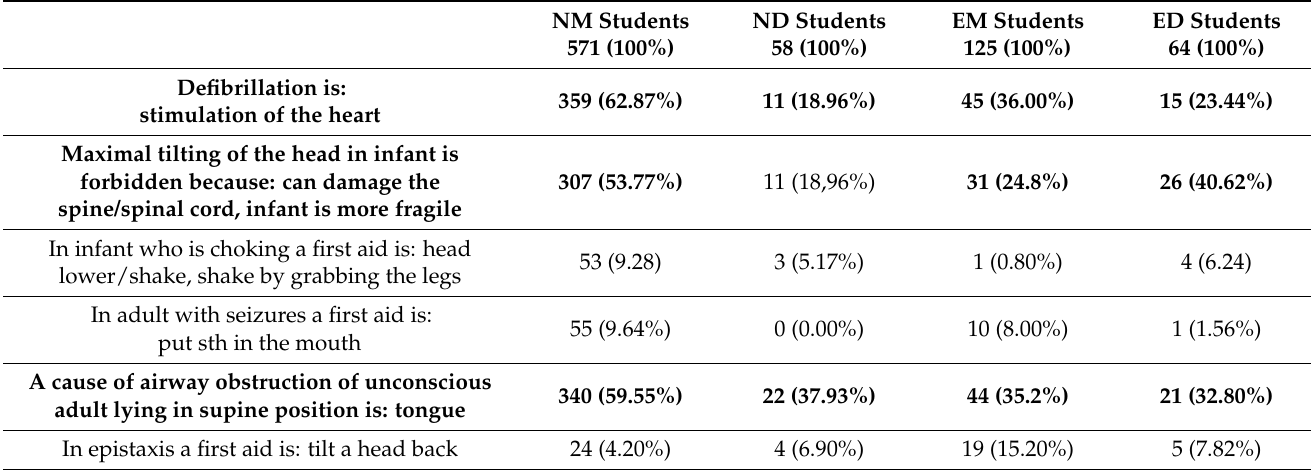
Table 4. Confirmed medical stereotypes in the questions (marked by bold). There is given a number of students who answered the questions in this